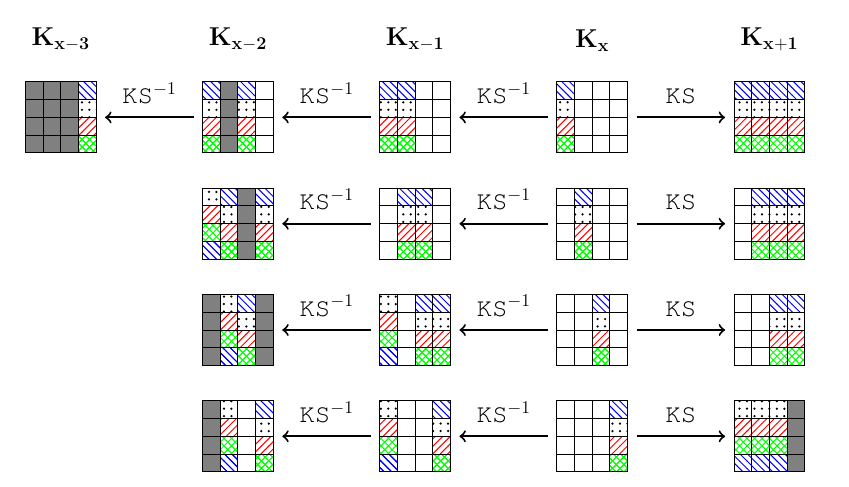
Figure 6: Backward and forward truncated differential transitions through the AES-128 key schedule when only one column is active in K x . The propagation of each active cells in K x can be traced using the same shade pattern. The white cells represent inactive bytes, while the gray cells can be either active or